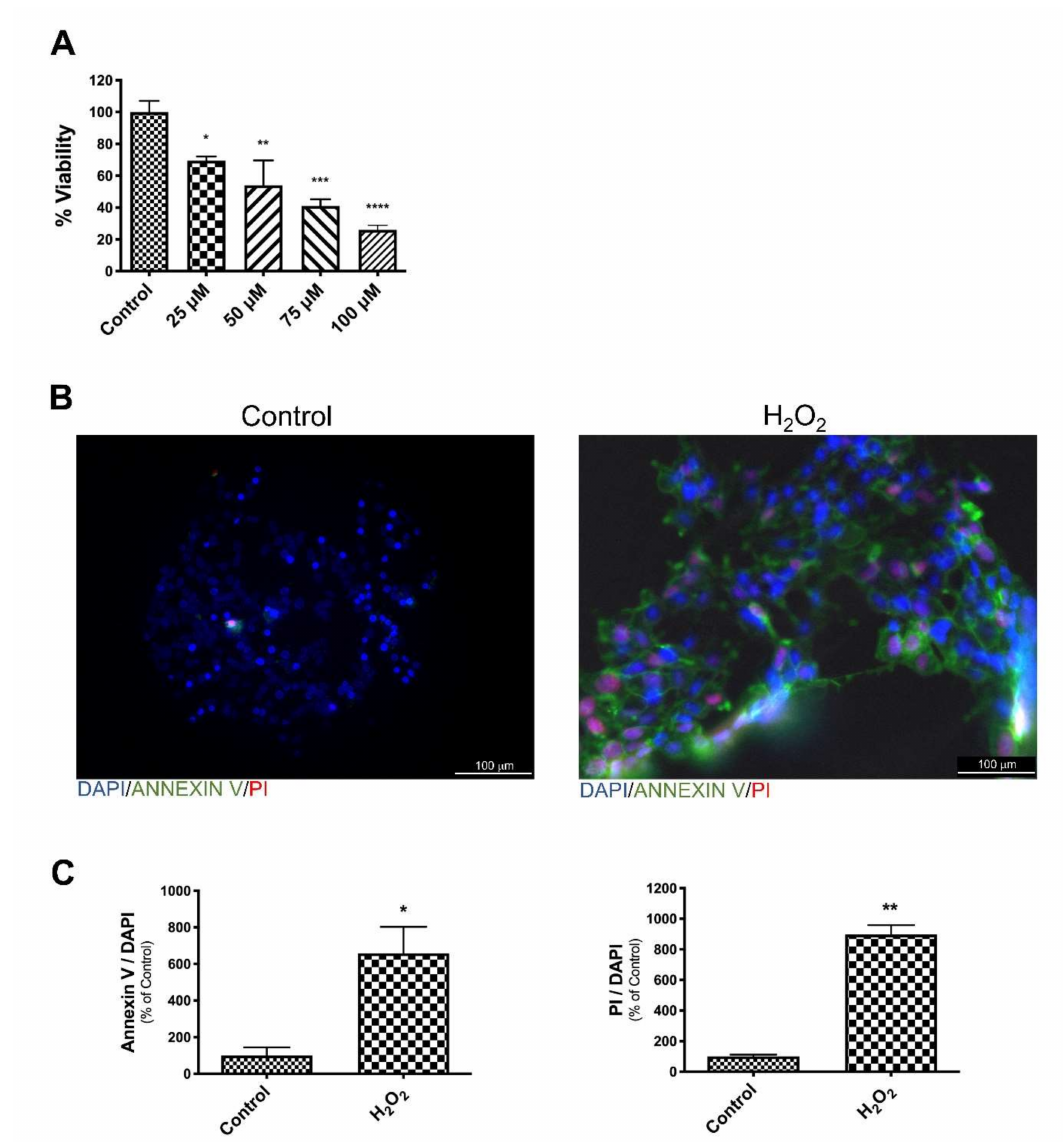
Figure 1. H 2 O 2 a ff ects SK-N-BE cell viability. Cell viability decrease after treatments with di ff erent concentration of H 2 O 2 ( A ). representative images of DAPI, Annexin V-FITC and PI triple fluorescence staining showing cellular apoptosis after H 2 O 2 treatment. DAPI: blue; AnnexinV: green; PI: red ( B ). Histograms reports quantification of fluorescence of DAPI, Annexin V, and PI ( C ). The bars represent ± the average ± SD of independent experiments ( n = 3). Statistically significant di ff erence compared to control cells: * p ≤ 0.05, ** p ≤ 0.01, *** p ≤ 0.001, **** p ≤